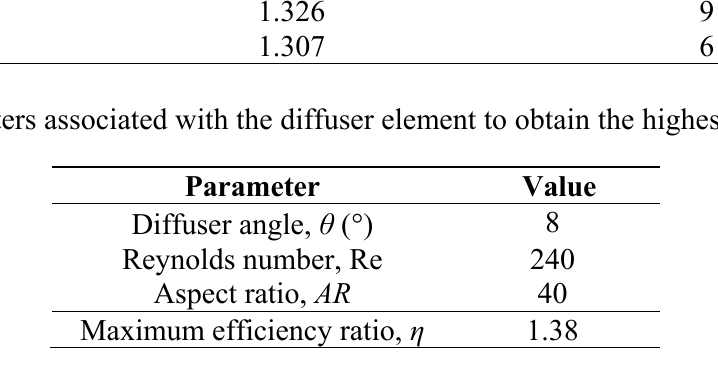
Table 9. Five highest efficiency ratios obtained along with the corresponding parameters generated using neuro-genetic